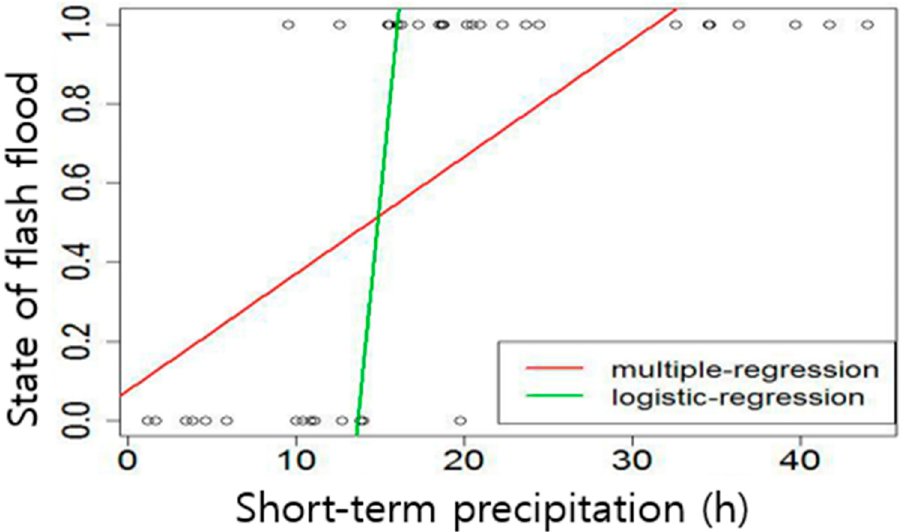
Figure 8. Scatter plot of short-term precipitation versus flash flood status. The circles indicate the 38 flooding occurrences. The red and green lines are respectively the results of the multiple linear regression and logistic regression.